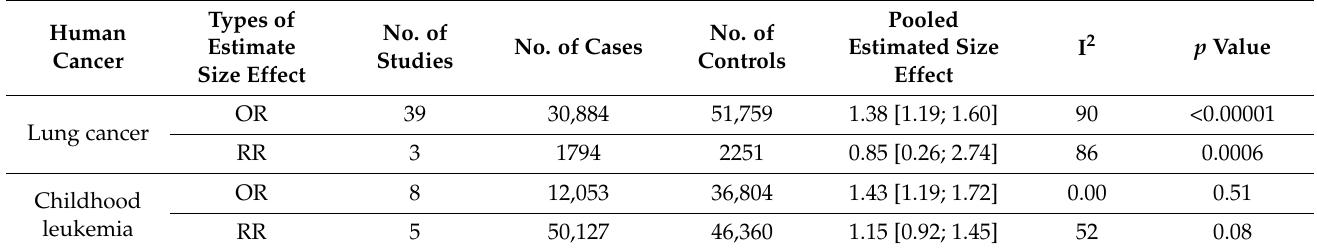
Table 2. Summary of pooled estimated size effects (95% CI) of case–control studies.